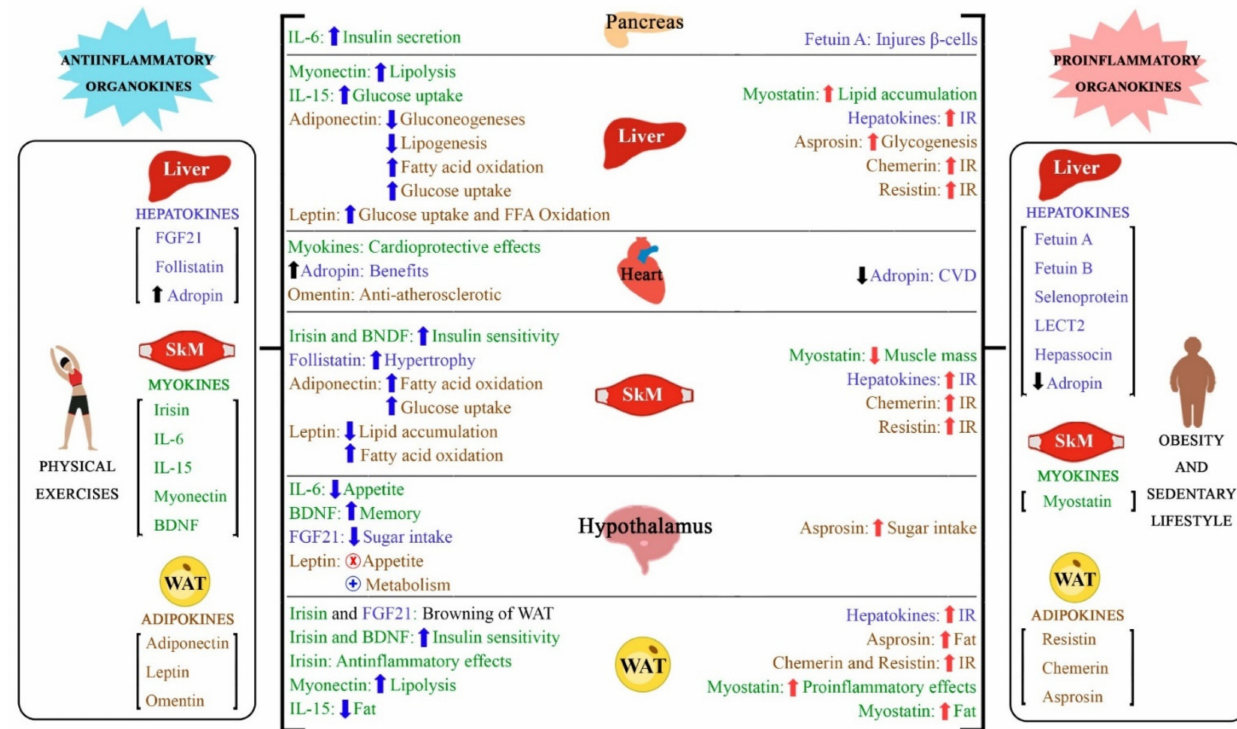
Figure 4. An overview of the crosstalk between adipokines, myokines and hepatokines. Adipokines are represented in brown, myokines in green and hepatokines in blue. The arrows that are indicating upward indicate an increase and downward decrease. (x) represents inhibition and (+) activation. Blue arrows are associated with benefits, while red arrows are associated with harm aspects. IL: interleukin; BDNF: brain-derived neurotrophic factor; FGF-21: fibroblast growth factor-21; SkM: skeletal muscle; WAT: white adipose tissue; CVD: cardiovascular disease; LECT2: leukocyte cell-derived chemotaxin 2; FFA: free fatty